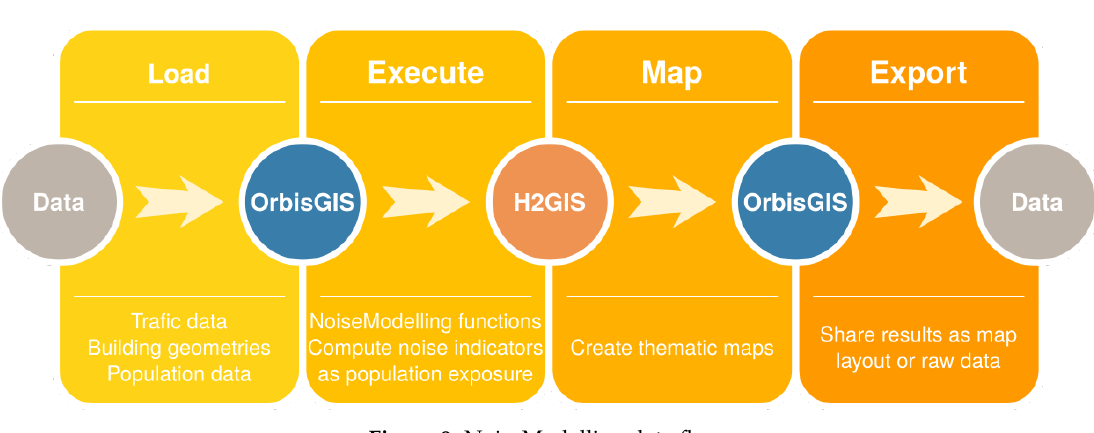
Figure 9. NoiseModelling data flow.